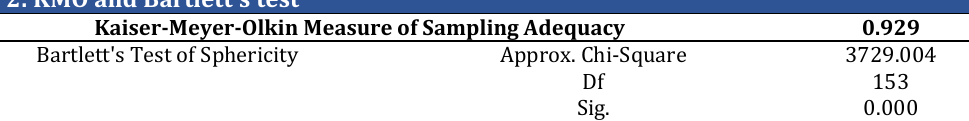
Table 2: KMO and Bartlett's test